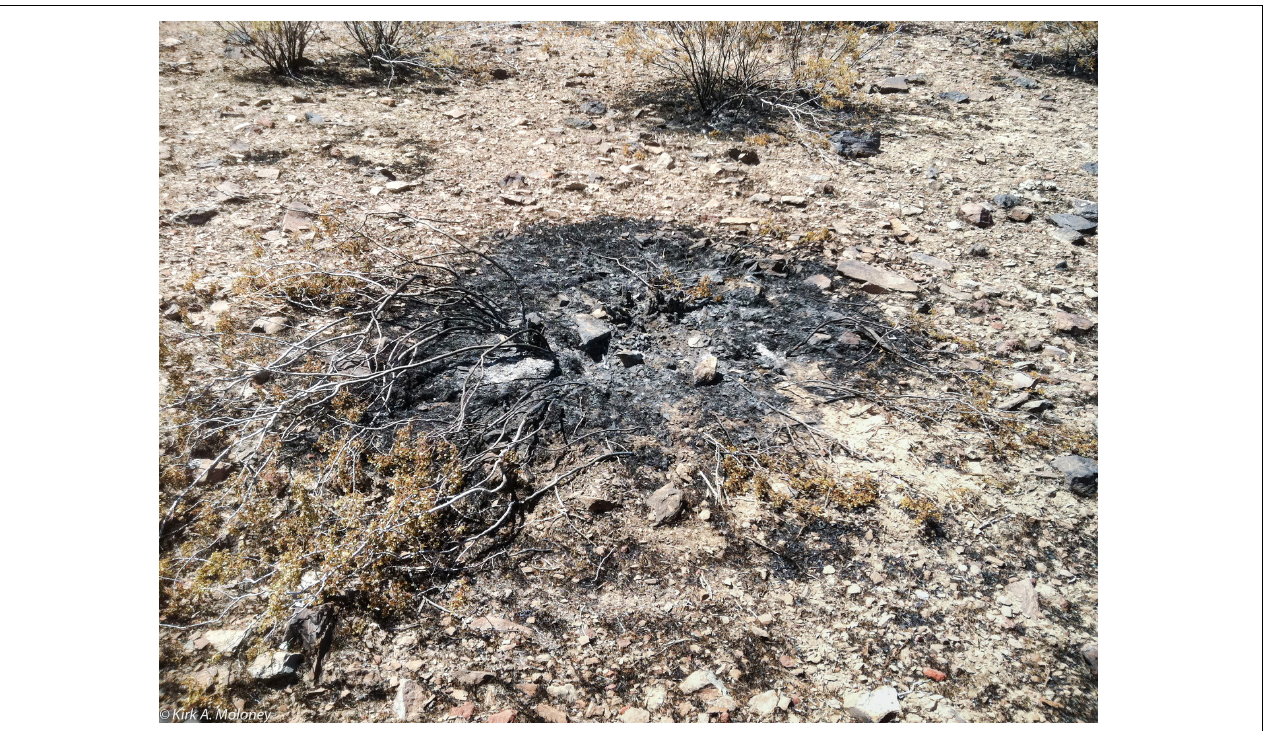
FIGURE 1 | Creosote shrubland fire on Fort Irwin Army Base, California in June of 2011. The fire was started by an exploding electrical transformer. The big fire scars seen in the photo are due to higher biomass of annual plants under creosote. The fire in the annuals was clearly hot enough with enough duration to burn the creosote stems. There is evidence of fire spread in the matrix in the right foreground where there is blackened plant material in the open. Photo by Kirk A.